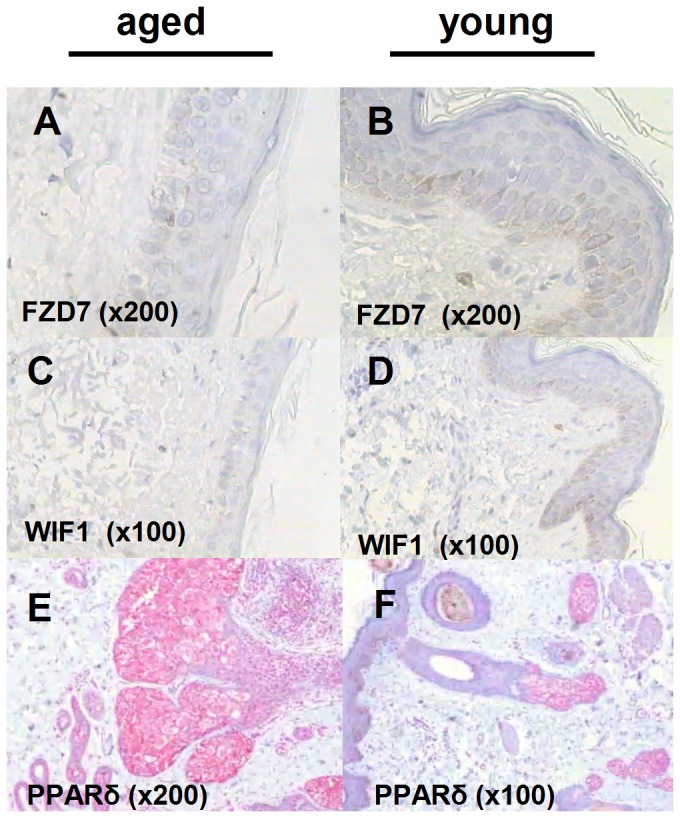
Protein expression of target genes via immunohistochemistry.A comparison between young and aged sun-protected skin provided by female and male healthy donors (n = 7, accordingly). Localization of WIF1 (A,B) and FZD7 (C,D) in aged and young skin, respectively [DAB staining, Dako]. The expression of both proteins was negative in skin biopsies obtained from elderly subjects. On the other hand, the young group showed a significant higher expression of both proteins (p = 0.0019 and p = 0.013, respectively) only in the basal cell layer of the epidermis. No significant gender differences were observed. E, F: Localization of PPAR-δ in aged and young skin, respectively [LSAB, REAL Detection System, Dako]. Strong immune reaction of the sebaceous glands in the skin of both groups and significantly stronger reaction of the sebaceous duct in the skin of the aged group (p<0.019). All experiments have been performed in triplicate.